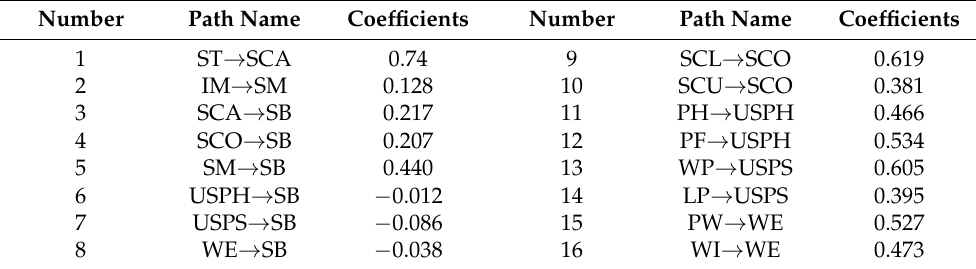
Table 2. Coefficients of system dynamics equation after